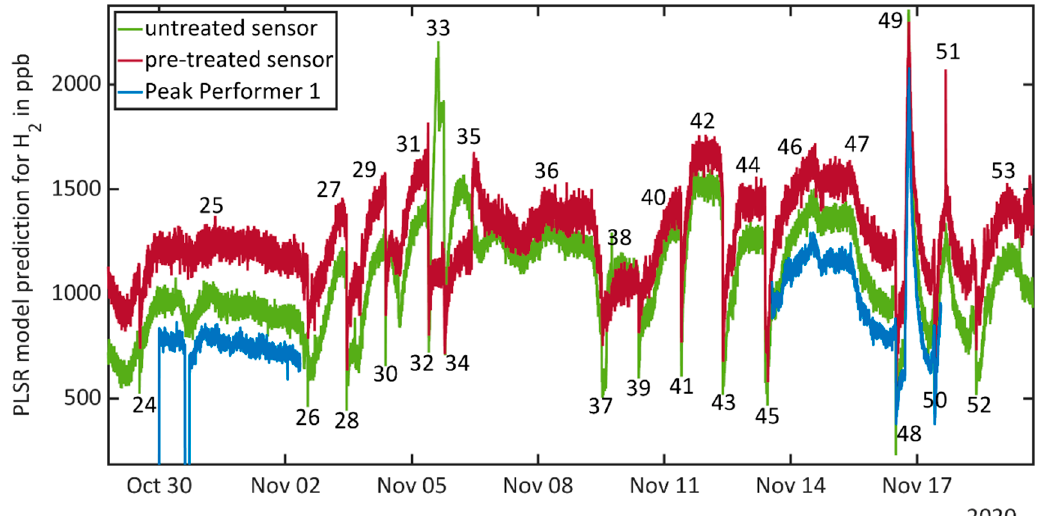
Figure 7. PLSR model predictions for H 2 from both sensors (untreated and pre-treated) over several days. Descriptions of the labelled events and periods can be found in Appendix A, Table A1.